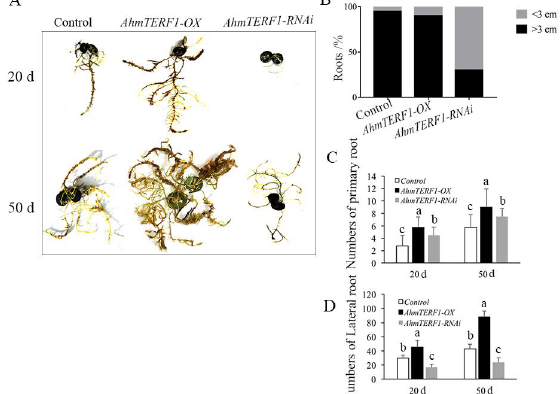
Figure 1. AhmTERF1 affects the growth of peanut hairy roots. ( A ): Phenotype of 20 d-old and 50 d- old peanut hairy roots in control, AhmTERF1 -overexpression ( AhmTERF1-OX ) and AhmTERF1 -silenced ( AhmTERF1-RNAi ) lines. ( B ): Proportion of roots of different length, i.e., <3 cm or >3 cm. ( C , D ): Number of primary roots and lateral roots in 20 d-old and 50 d-old seedlings. Lower case letters (a, b, c) indicate significantly different groups ( p < 0.05).